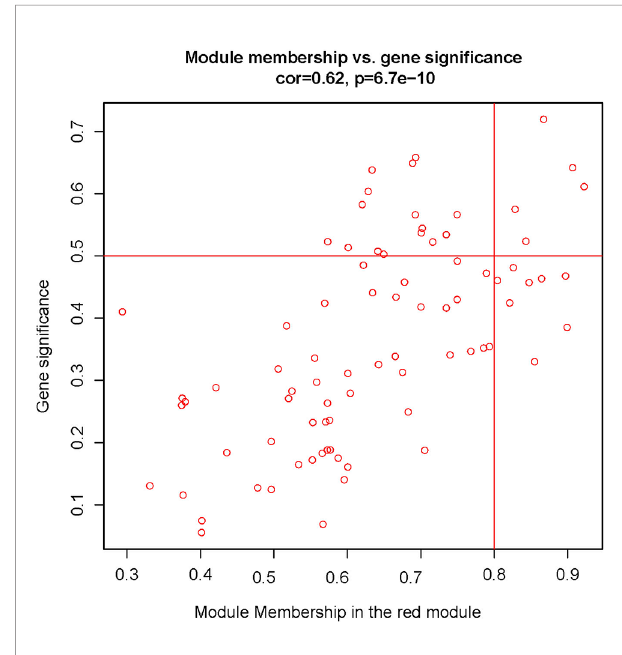
FIGURE 5 | Scatter plots of the red Veri fi cation of the Expression Patterns and Prognostic Values of Hub Genes To con fi rm the reliability of the hub genes, the expression of the top ten hub genes between chemotherapy-sensitive and chemotherapy-resistant samples was plotted as a box plot graph. Seven hub genes showed signi fi cant differences between chemotherapy-sensitive and chemotherapy-resistant samples ( Figure 8 ). To evaluate the prognostic value of the seven genes, the chemotherapy patients from TCGA COAD were